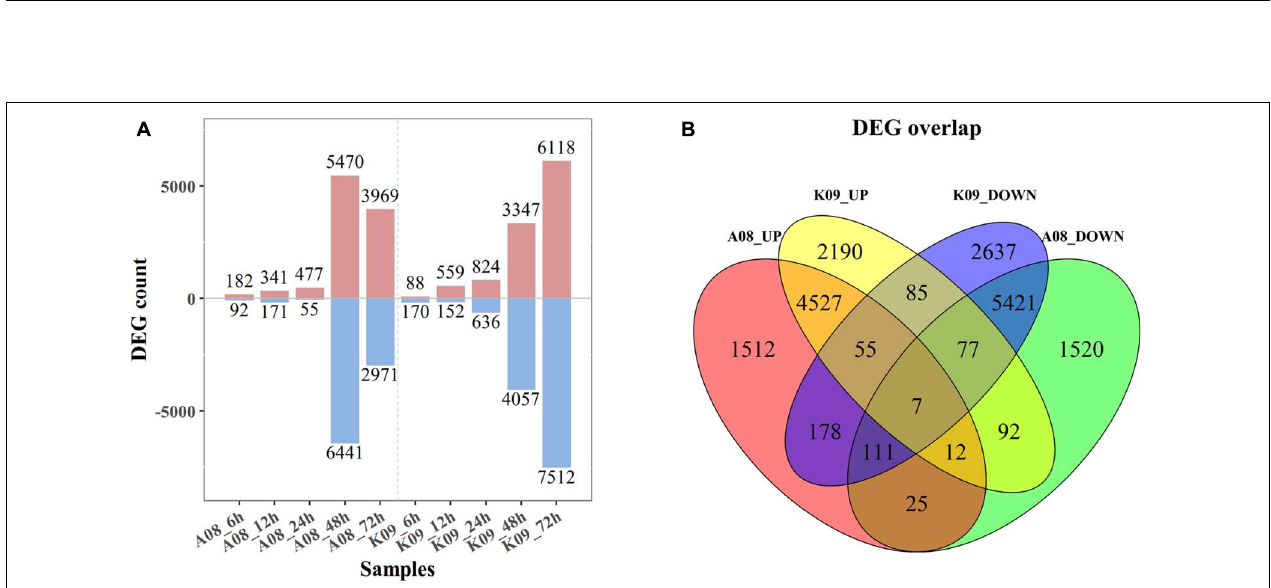
FIGURE 2 | RNA-seq analysis of K09 and A08 upon infection with F. graminearum . (A) The total number of up- and down-regulated differentially expressed genes (DEGs) at 6 h postinoculation (hpi), 12, 24, 48, and 72 hpi in A08 and K09, respectively, after inoculation with F. graminearum . (B) The Venn diagram displaying differentially expressed transcripts unique and common between K09 and A08. The number of up-regulated and down-regulated genes is indicated by red and blue fonts, respectively.